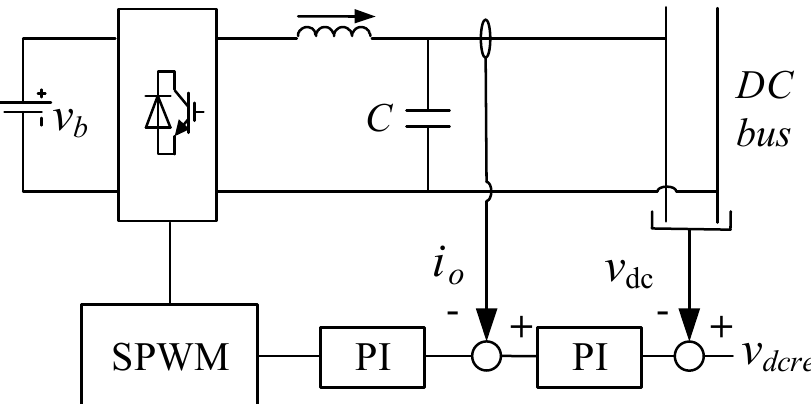
Figure 8. Control strategy block diagram of battery controlling DC bus voltage.